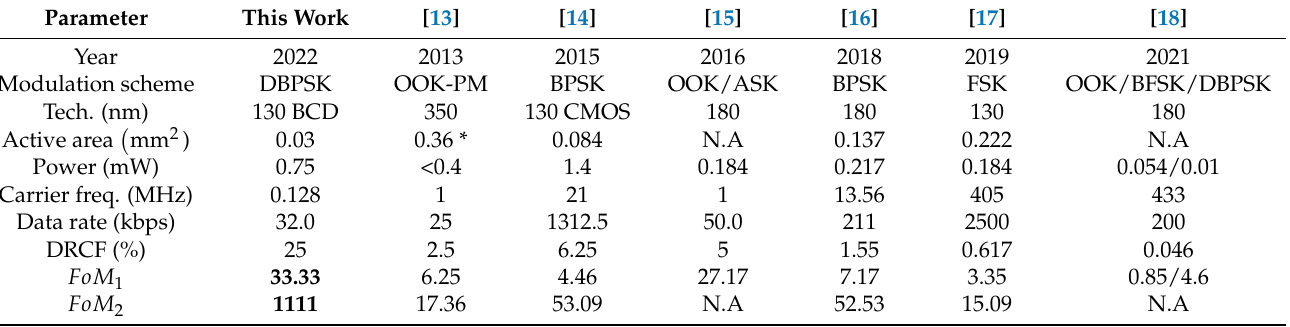
Table 1. Performance of the proposed DBPSK demodulator and comparison with other